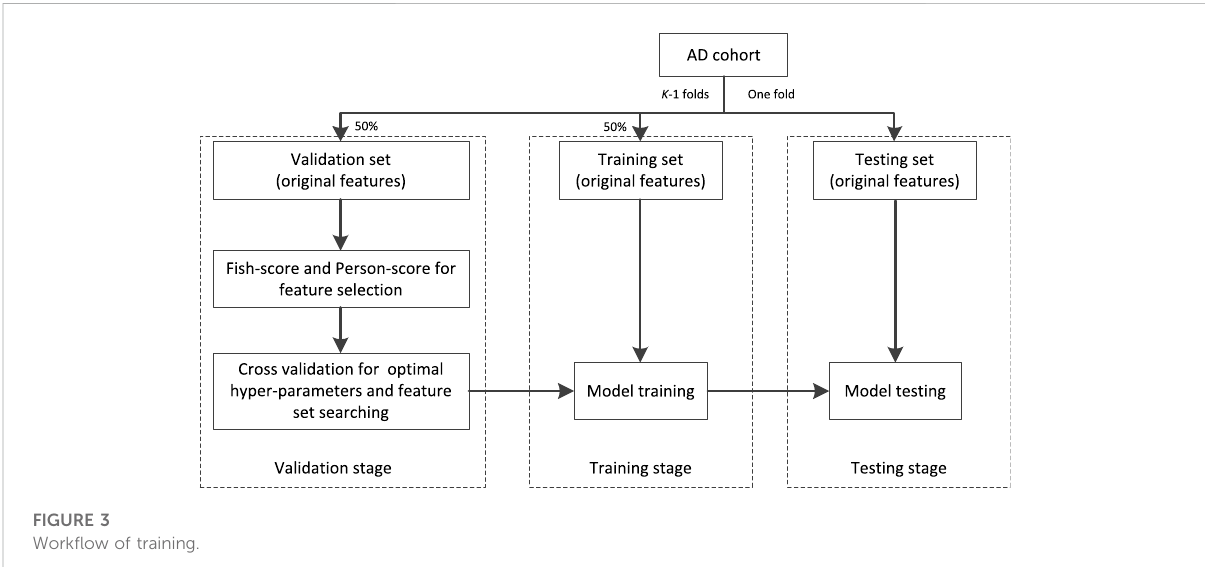
FIGURE 3 Work fl ow of